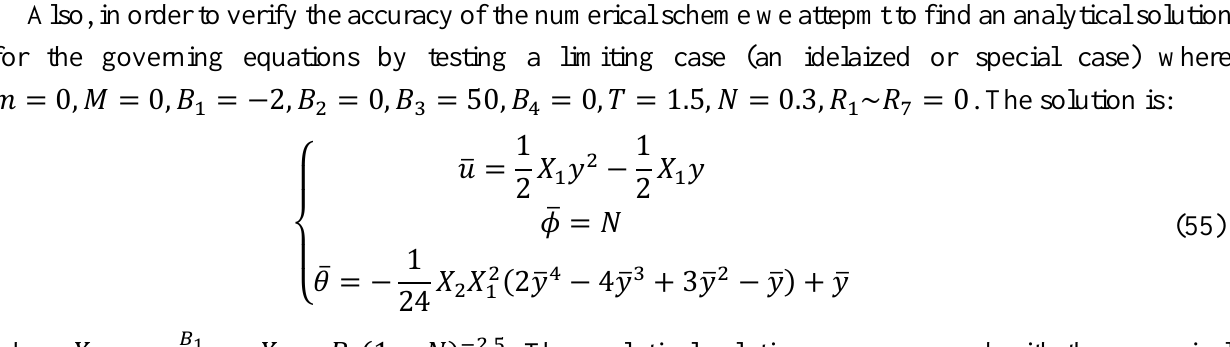
Figure 2. ( a ) velocity profiles ( b ) volume fraction profiles ( c ) temperature profiles under different mesh sizes. 𝑚 = −0.3, 𝑀 = 1, 𝐵 𝑁 = 0.3, 𝑅 ~𝑅 = −0.1, 0.02, −0.02, 0.01, 2.3, −9, 1 7